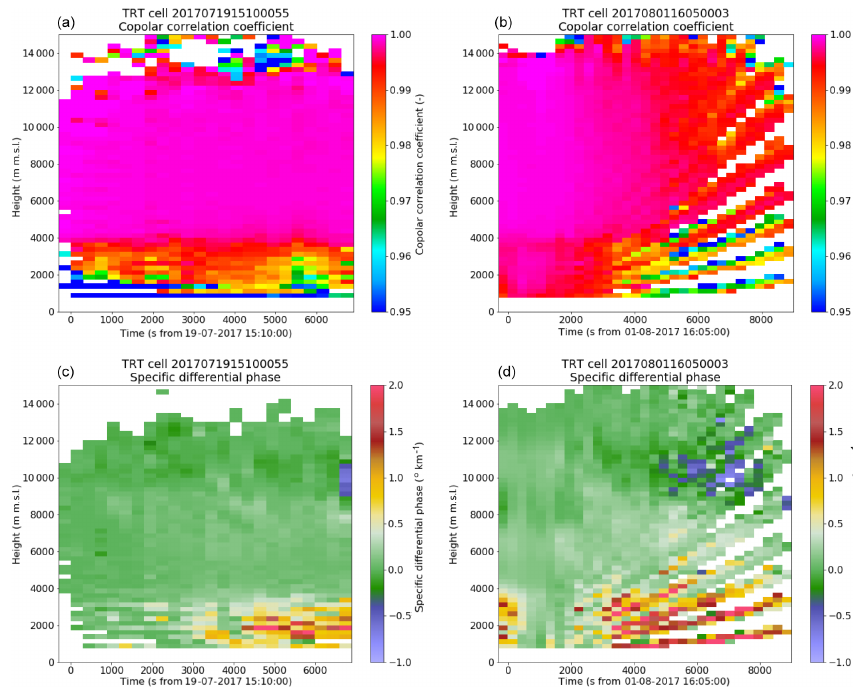
Figure 15. (a, b) Profile of ρ hv ; (c, d) profile of K dp . (a, c) Cell 1; (b, d) cell 2.